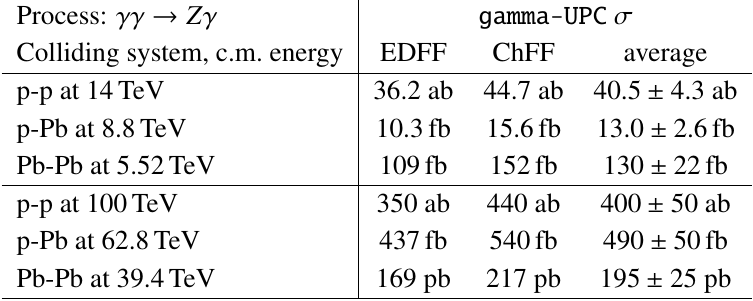
Table 8 . Total SM cross sections for (cid:13)(cid:13) ! Z (cid:13) in UPCs at the LHC and the FCC-hh, computed with EDFF and ChFF (cid:13) fluxes and their average.